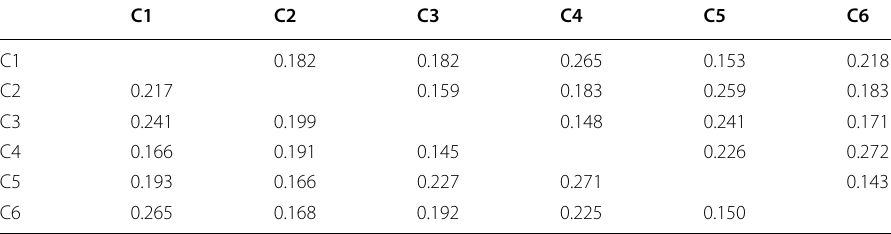
Table 15 Relation